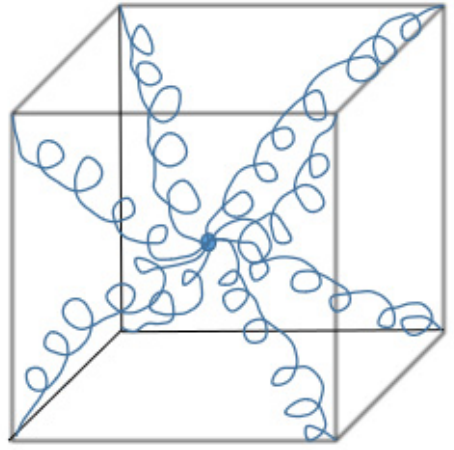
Figure 7. Schematic drawing of the Arruda–Boyce